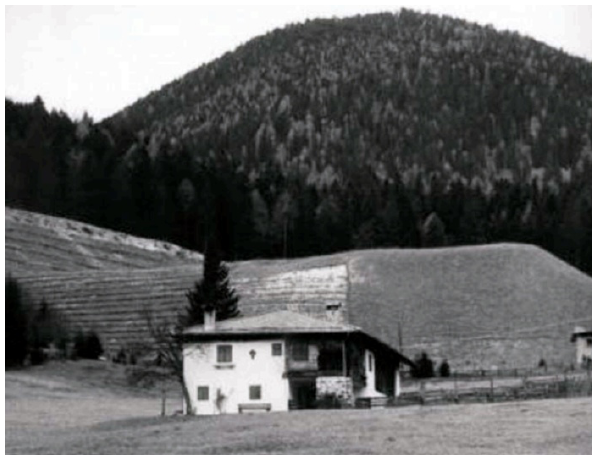
Fig. 3. 1981–1982: bottom view of the two basins almost com-